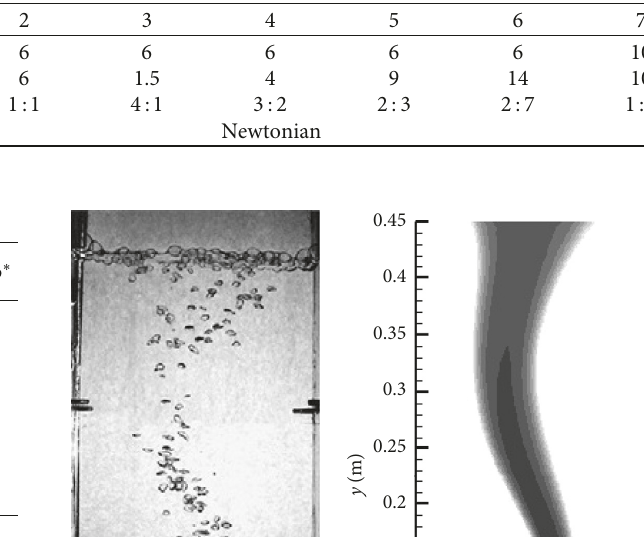
Table 1: Parameters for different calculation cases.